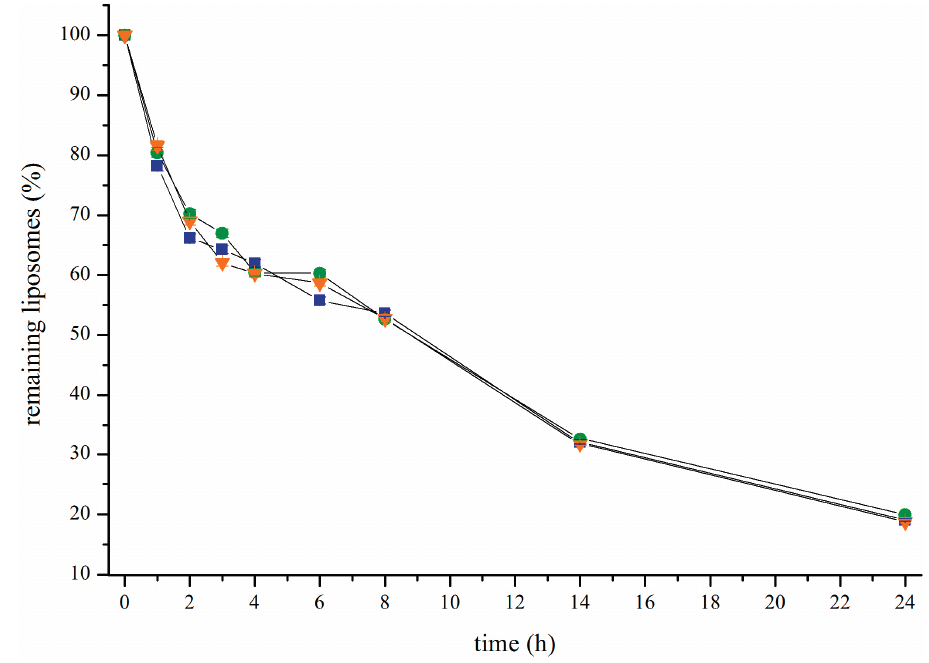
Figure 9. Remaining liposomes in the bloodstream of three rats over a time course of 24 h. The clearance of cBSA-liposomes over 24 h is low and seems to be slow enough to permit the uptake into brain tissue. It stands to reason that, aside from the brain, other organs are involved in liposome uptake as